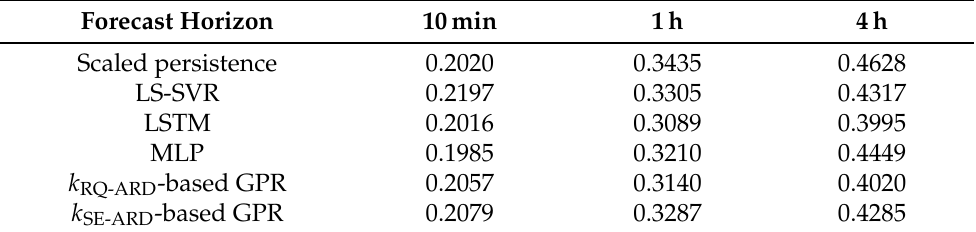
Table 2. nRMSE values for all the models included in the comparative study.